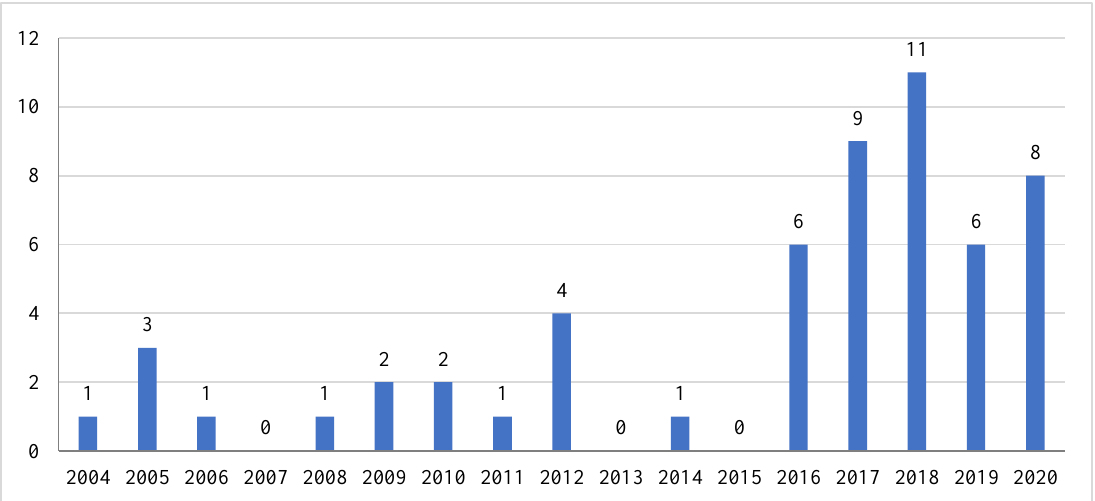
Figure 3. Publications teaching research